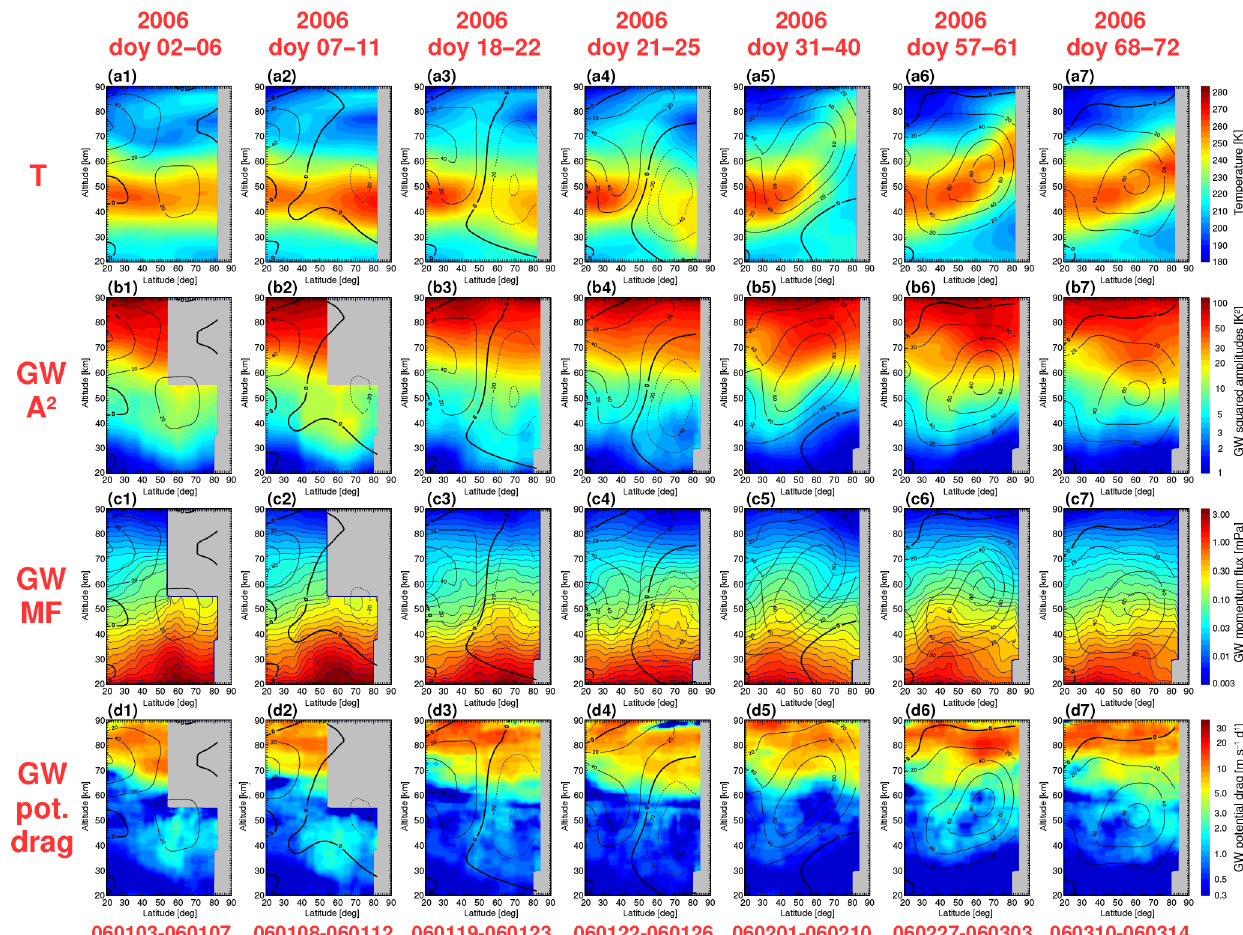
Figure 10. Zonal average cross-sections of MLS temperatures (upper), as well as a combination of HIRDLS and SABER gravity wave squared amplitudes in K 2 (second row), momentum fluxes in mPa (third row), and potential drag in ms − 1 day − 1 (lower) for the latitudes 20–90 ◦ N during different phases of the strong major SSW in winter 2005/2006. For the lower three rows logarithmic color scales are used. Overplotted contour lines indicate the zonal average of MLS geostrophic zonal winds, averaged over the respective time periods shown. Contour interval is 20ms − 1 . Dashed contour lines indicate westward